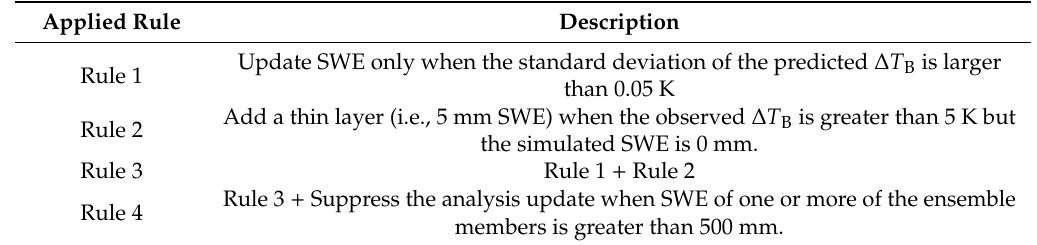
Table 4. Descriptions of rule-based updates incorporated into the SVM-DA